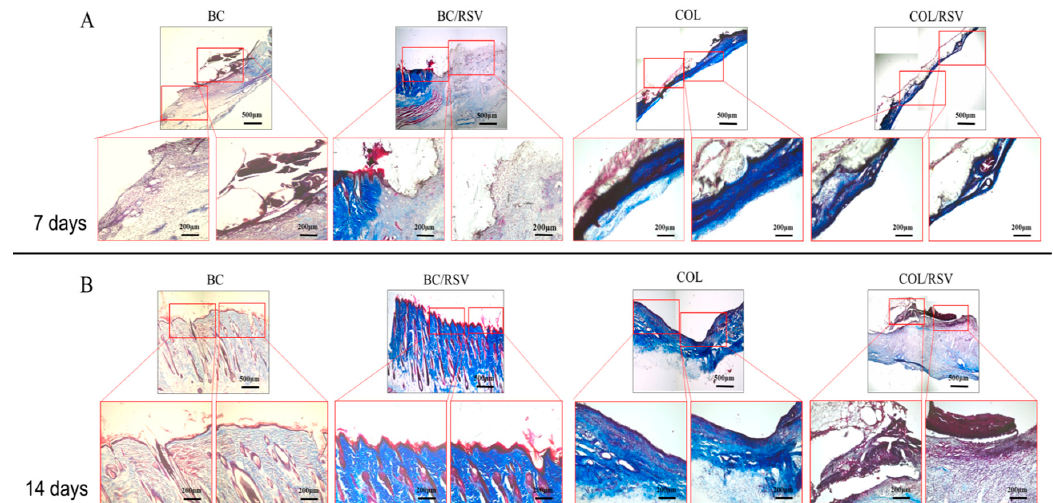
Figure 9. Histological assessment of scaffold implants in skin defects after 7 and 14 d. ( A ) Masson’s trichrome staining demonstrated that COL bundles formed after 7 d in the wound treated with RSV-loaded BC and COL scaffolds; ( B ) after 14 d, remodeling progress was improved in the presence of the BC/RSV scaffolds relative to the COL/RSV scaffolds. Relatively greater COL accumulation and deposition were observed in the COL scaffolds. Light micrographs of Masson’s trichrome staining show that the BC/RSV scaffolds preserved normal COL-bundling patterns and orientation.